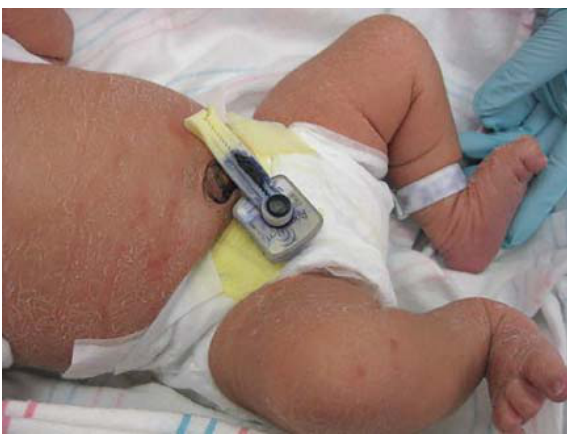
Figure 10. Secondary syphilis.